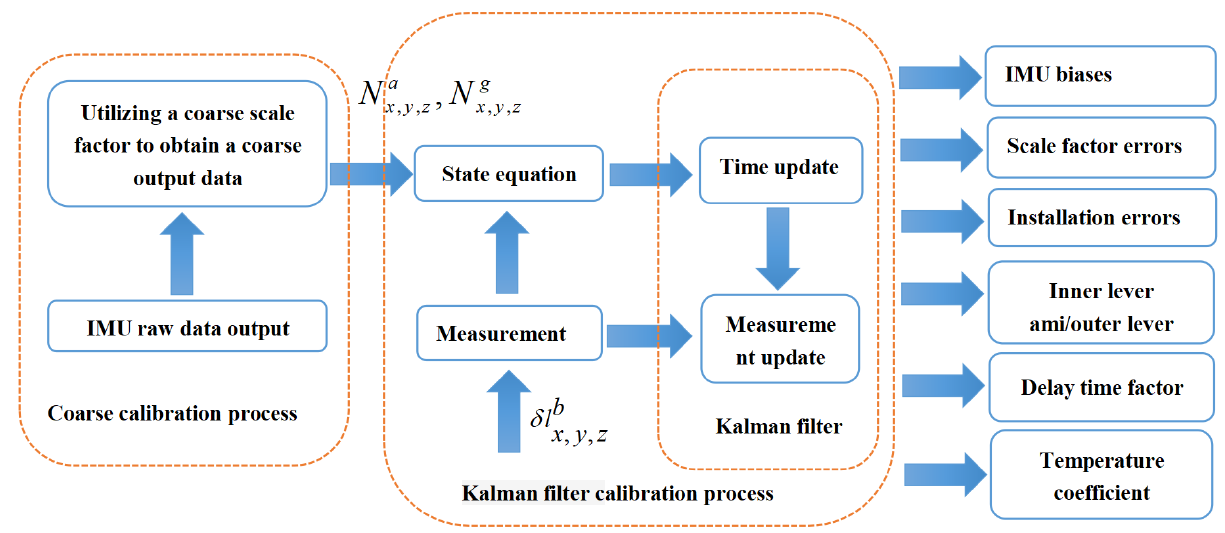
Figure 4. Schematic diagram of size